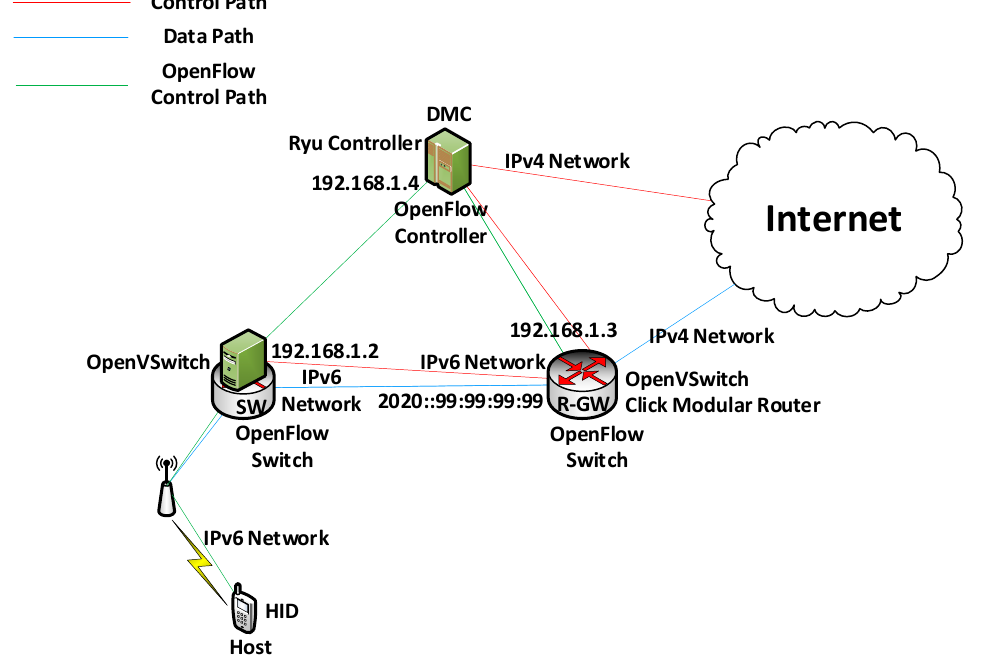
Figure 21. Intra-domain network Figure 21. Intra ‐ domain network architecture.